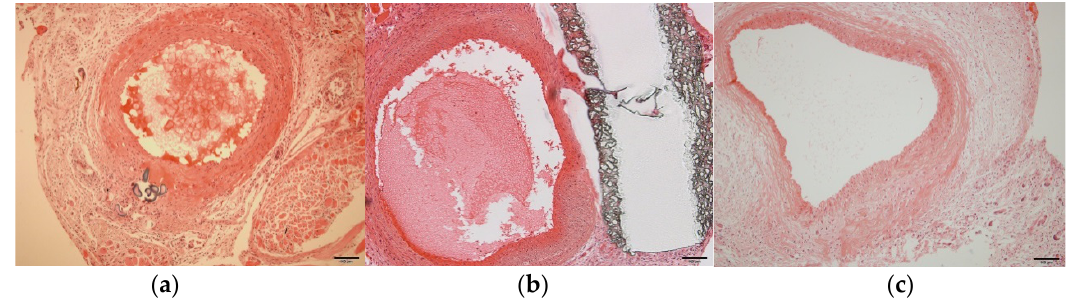
Figure 7. Three-week post-operation histological examination results: ( a ) direct closure as the control group; ( b ) PTFE group; ( c ) 4-HR silk group (hematoxylin and eosin stain, original magnification ×100, scale bar = 100 μm).